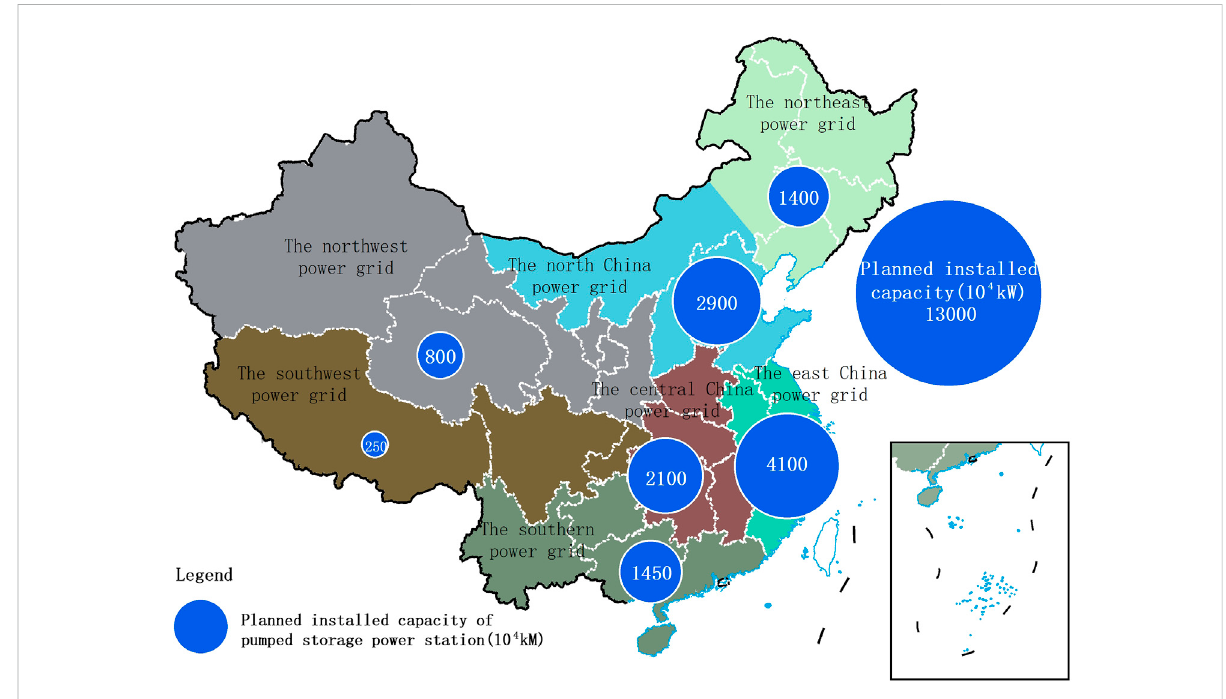
FIGURE 10 Spatial distribution of planned installed capacity of PSPS.